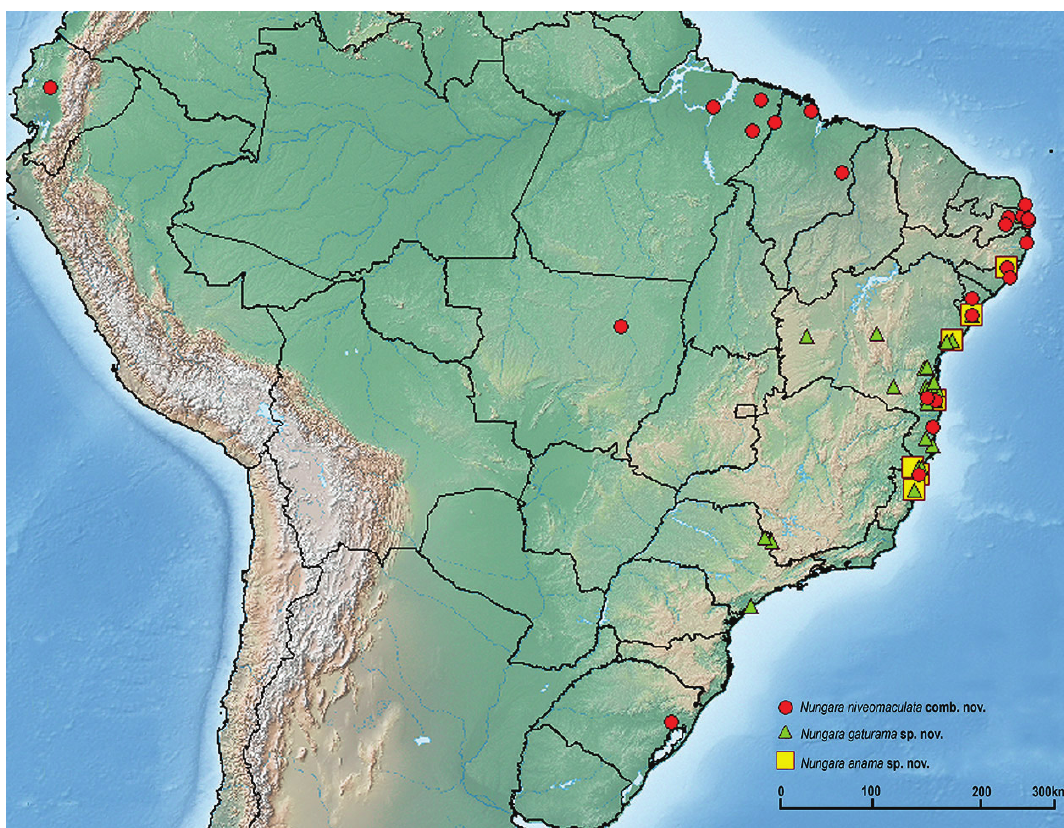
Figure 60. Distribution map for the known species of Nungara gen.